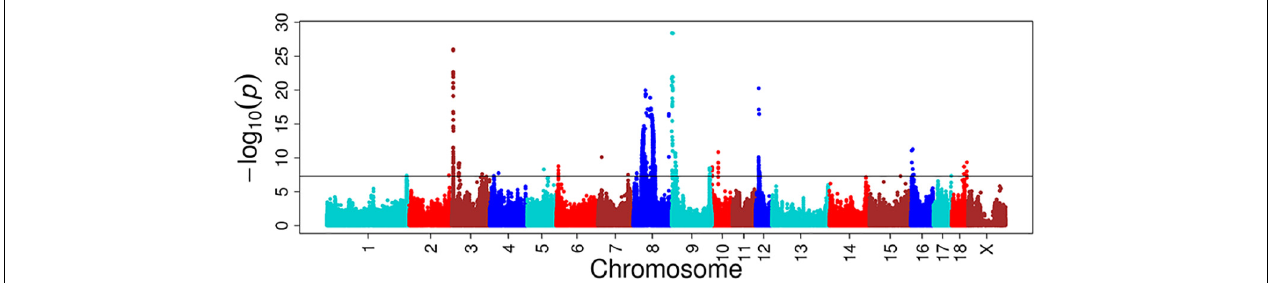
FIGURE 4 | Multitrait GWAS results for correlated hematological traits at day 18. The multiple traits include HCT, HGB, MCH, and MCV at day 18. The y -axis and the x -axis represent the negative log 10 P-value of the SNPs and the genomic positions separated by chromosomes, respectively, and the black solid lines indicate the significance threshold (negative log 10